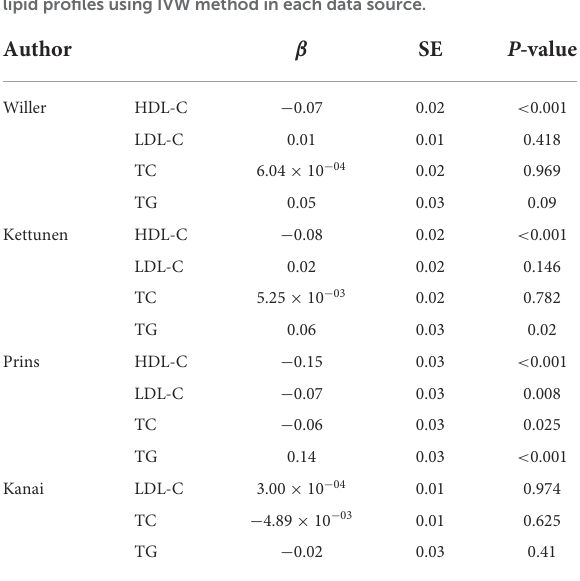
TABLE 2 Genetic association for the causal effect of T2DM on blood lipid profiles using IVW method in each data source.